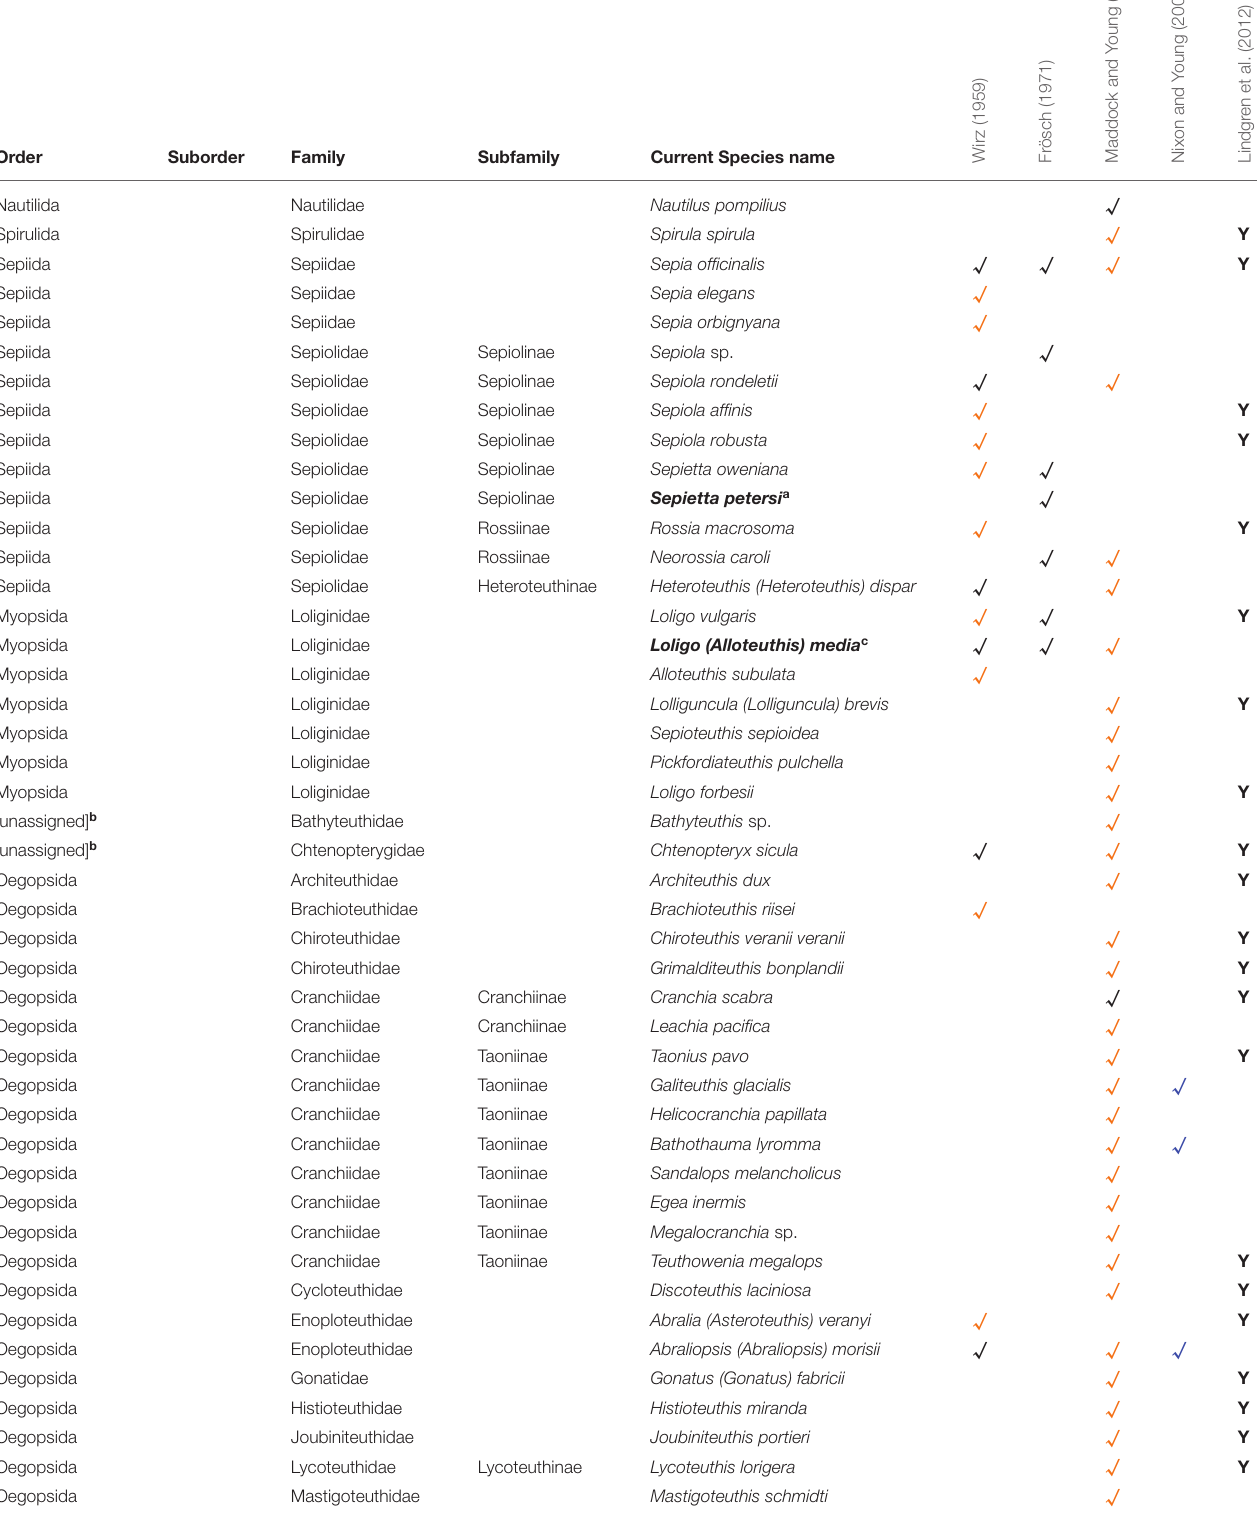
TABLE 1 | List of species ( √ , N 81) included in the three published reports including quantitative data of brains in cephalopods (Wirz, 1959; Frösch, 1971; Maddock = and Young, 1987).